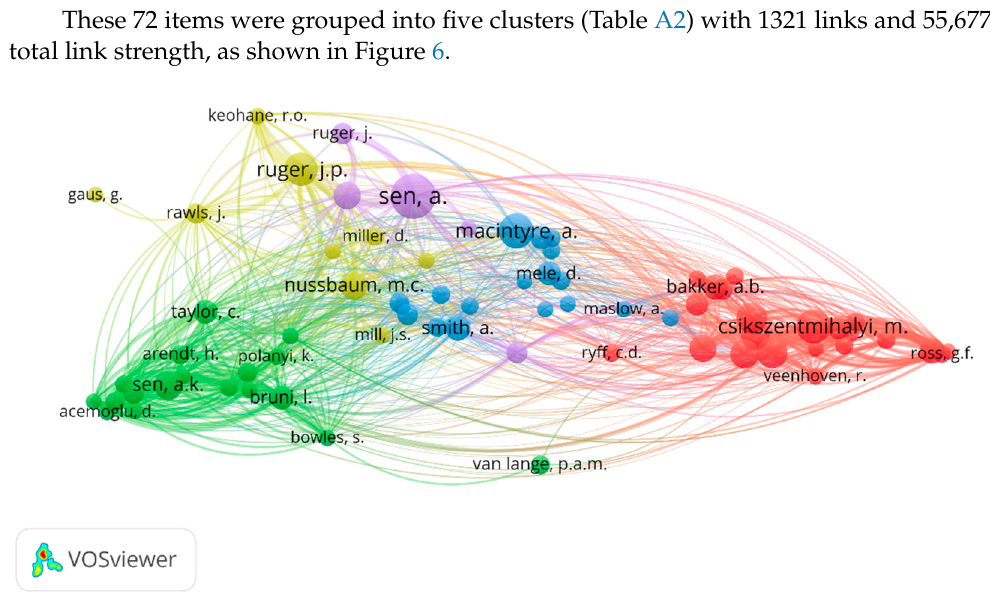
Figure 6. Co-citation visualization (human flourishing—SCOPUS). Cluster 1 (Red), Cluster 2 (Green), Cluster 3 (Blue), Cluster 4 (Yellow), Cluster 5 (Violet).